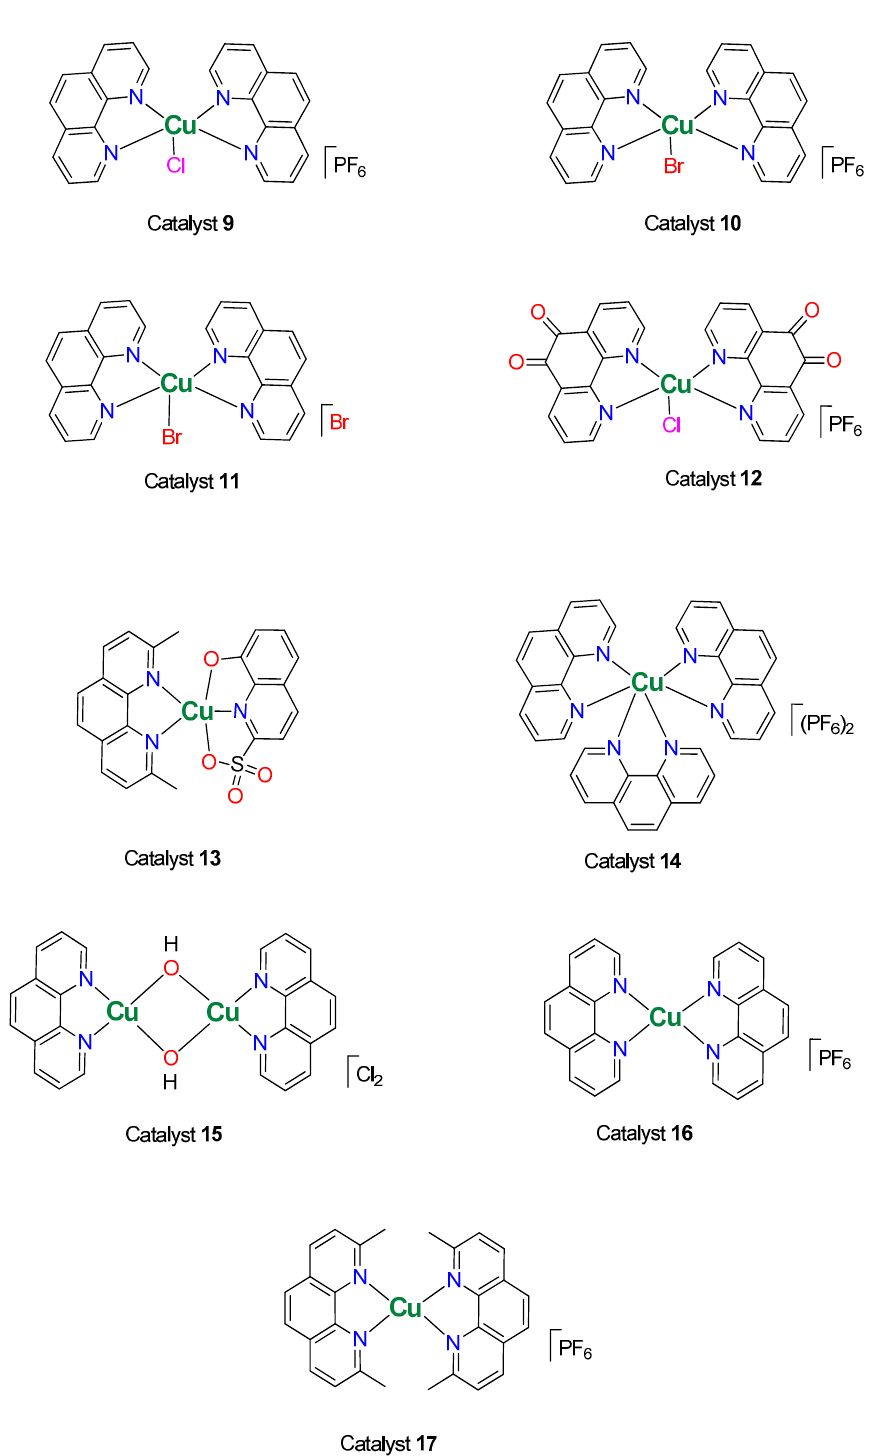
Figure 8. Complexes studied as catalysts, adapted from Ref. [72], Copyright (2020) with permission of Elsevier.